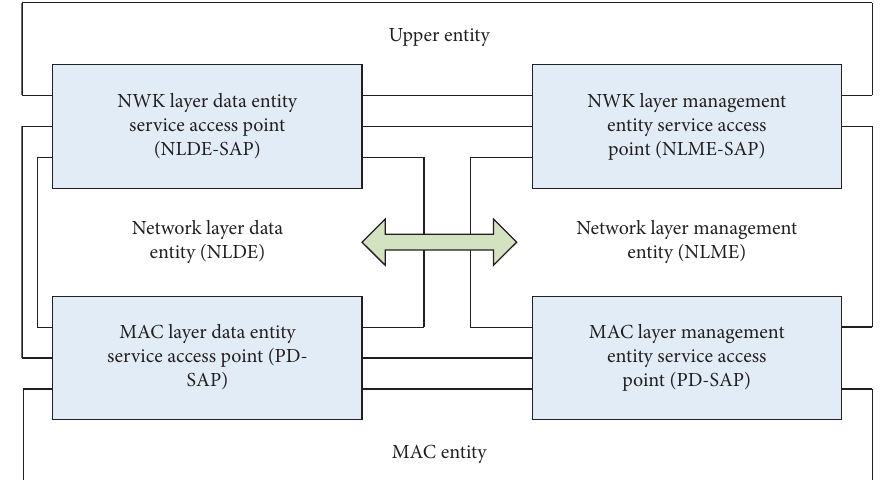
Figure 1: Network layer reference